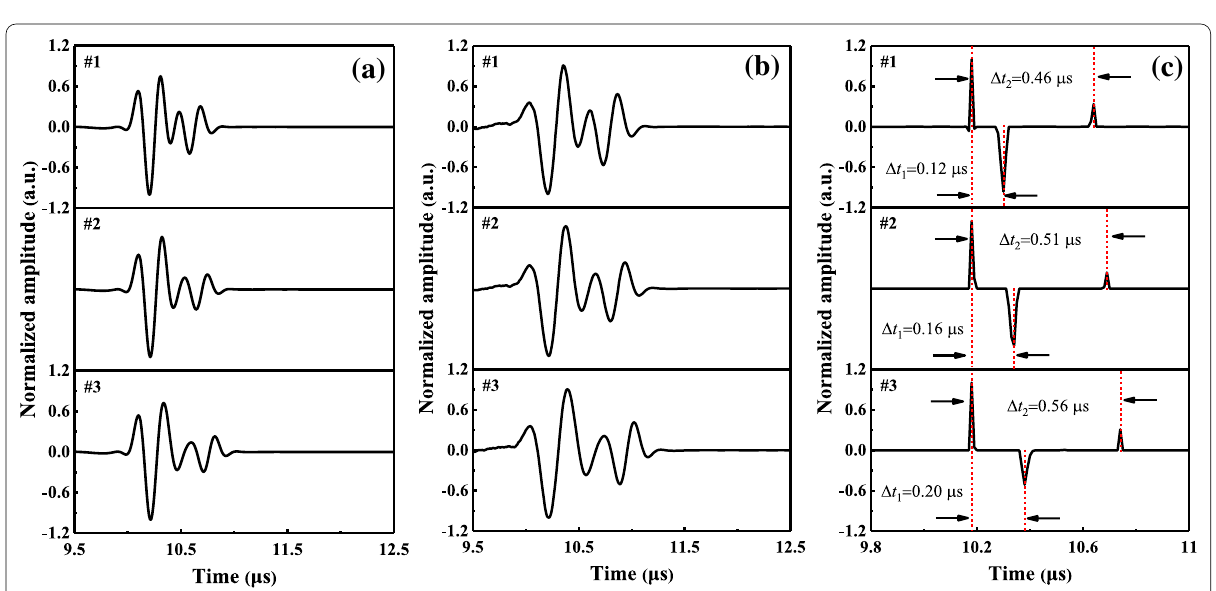
Figure 5 A-scan signals corresponding to the three cracks in different images: ( a ) in the original image, ( b ) in the reconstructed image by conventional SAFT, ( c ) in the reconstructed image by